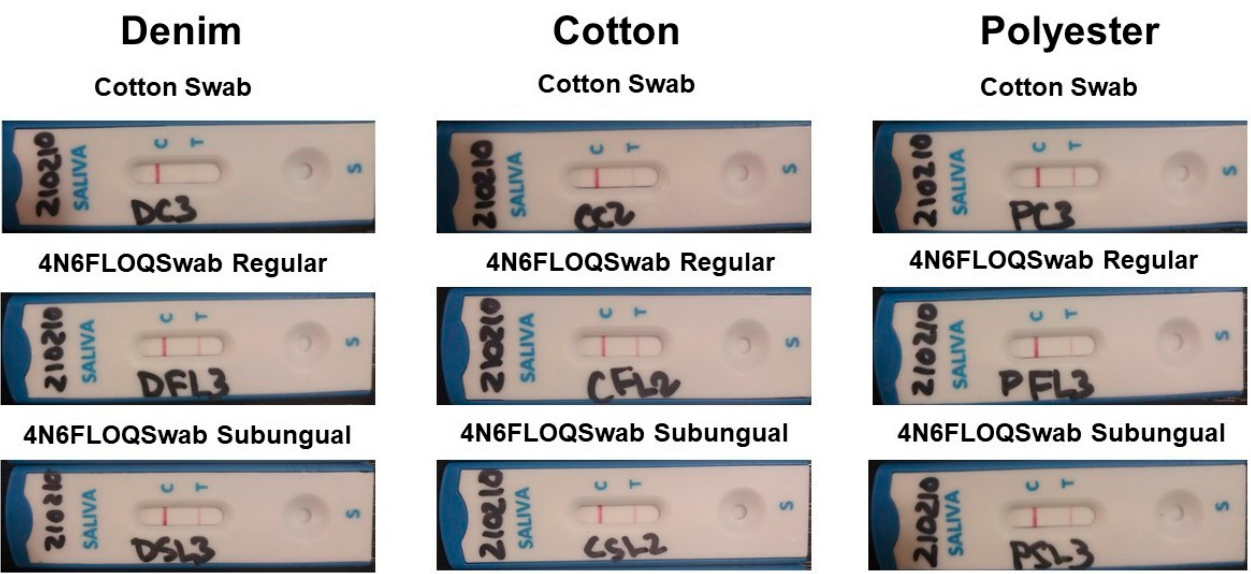
Figure 1. Representative results of immunochromatographic tests per fabric and swab type. All results are positive in these images. As examples of scale values, the cotton swab in denim fabric in the first line shows a weaker band G3.5; in the same fabric, Regular FLOQ swabs show a G8 intensity as well as the subungual swab.